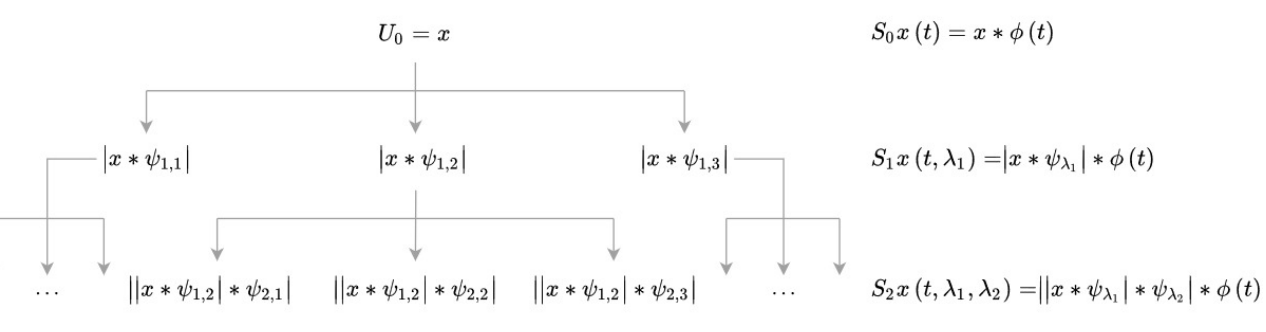
Figure 2. Wavelet scattering spectrum transform.